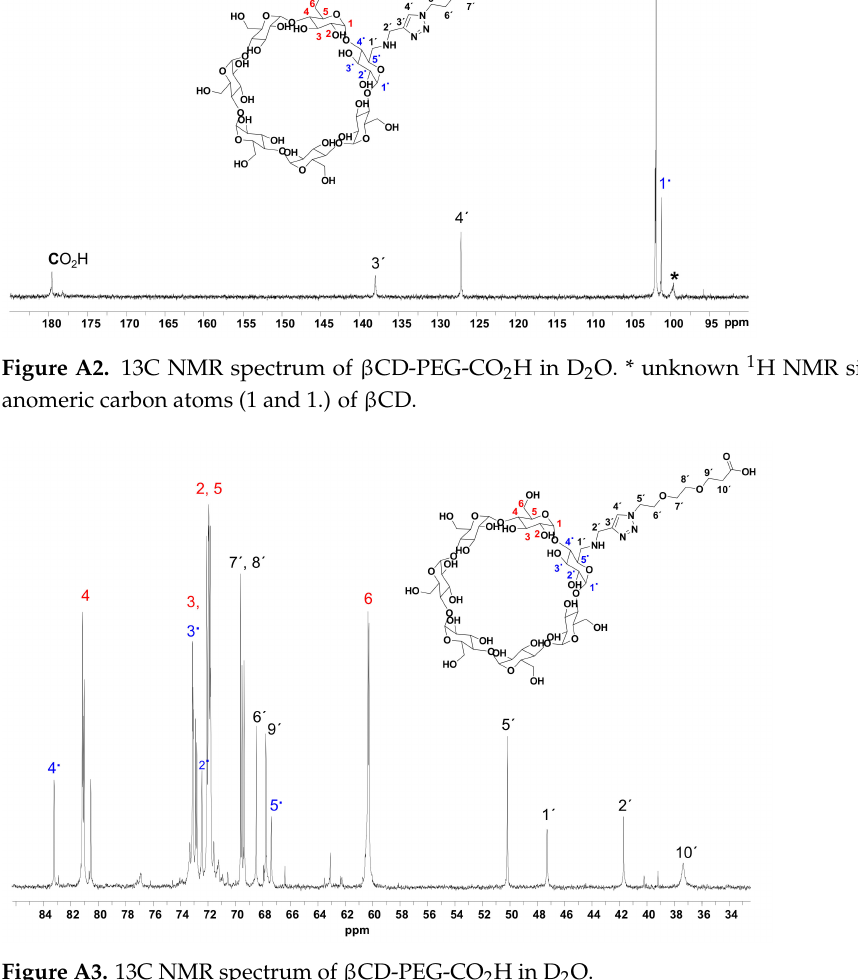
Figure A3. 13C NMR spectrum of β CD-PEG-CO 2 H in D 2 O.